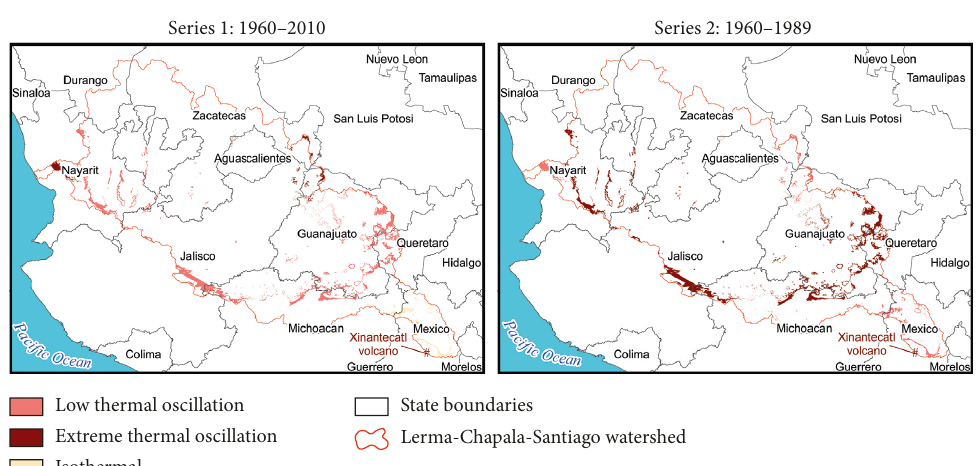
Figure 7: Areas of the watershed with changes in thermal oscillation between time series one (1960–2010) and time series two